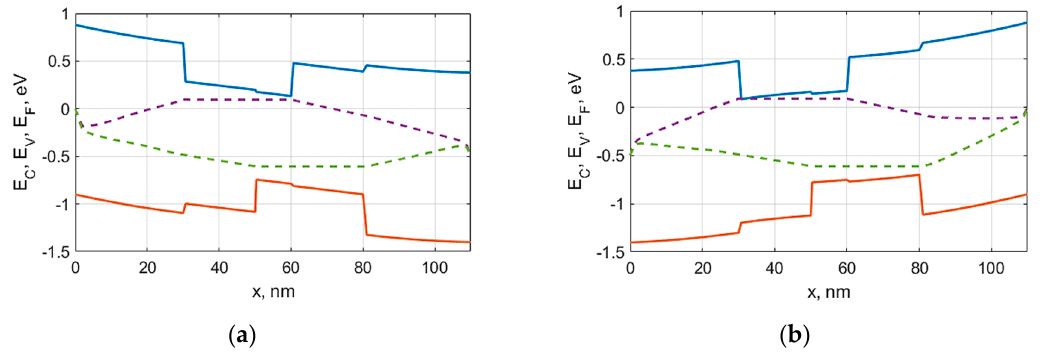
Figure 3. The energy band diagrams (solid lines) and spatial distributions of electron and hole quasi-Fermi levels (dashed lines) in the control heterostructure of the photodetector with controlled relocation of carrier density peaks (20-nm LT/10-nm i -type/20-nm LT configuration): ( a ) Just before the back edge detection; ( b ) Immediately after the end of the carrier relocation process.